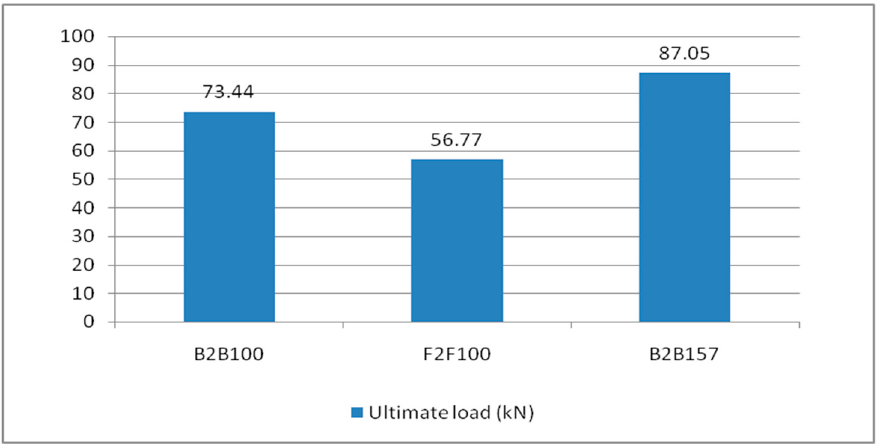
Figure 6. The ultimate load capacity of the built-up section.